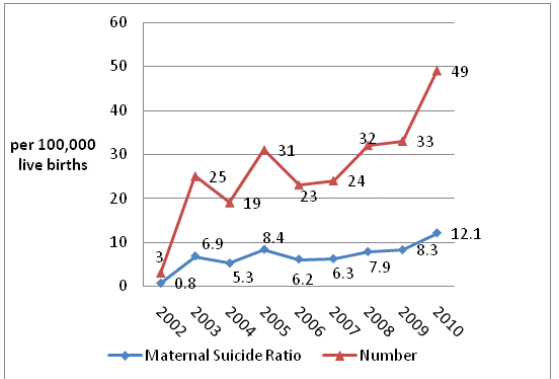
Figure 1. Maternal suicides 2002-2010. Reproduced, with permission from K. Jayaratne.